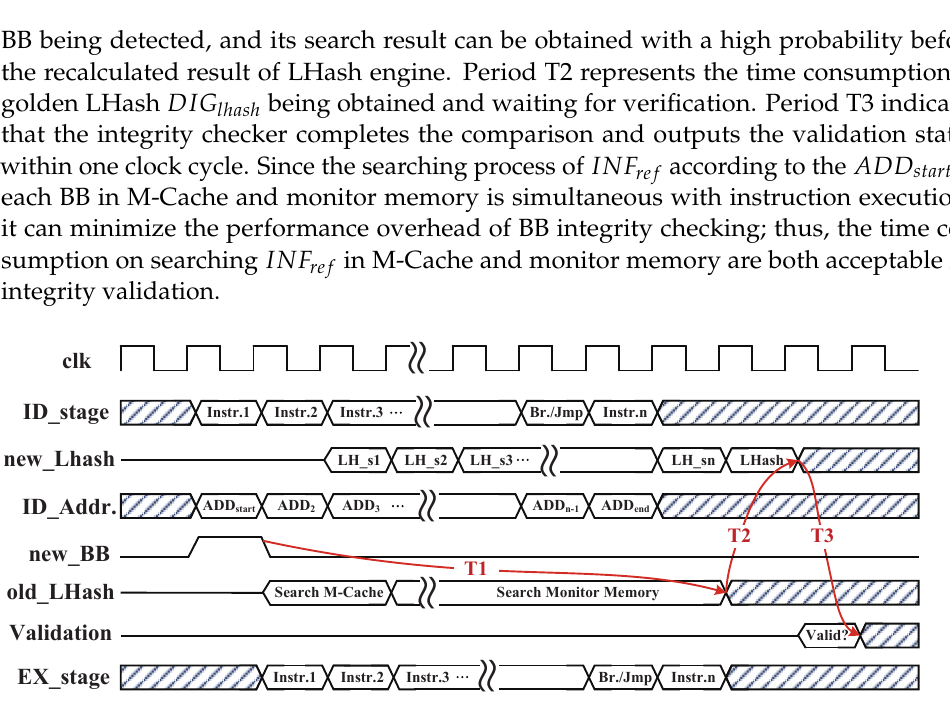
Figure 7. The timing diagram of a BB execution with integrity validation at the worst situation.